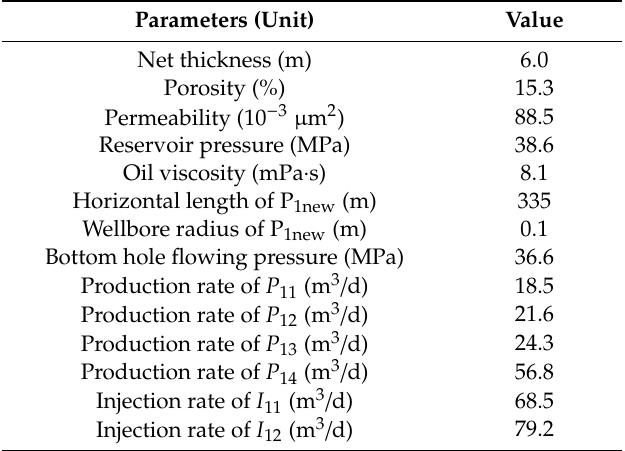
Table 1. Productivity calculation parameters of P 1 new .